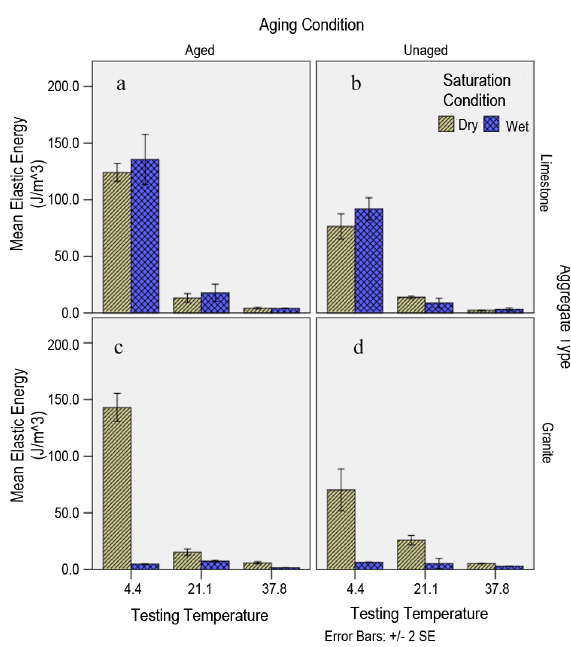
Fig. 5. Resilient modulus of: a) limestone aged mixtures; b) limestone un-aged mixtures; c) granite aged mixtures;